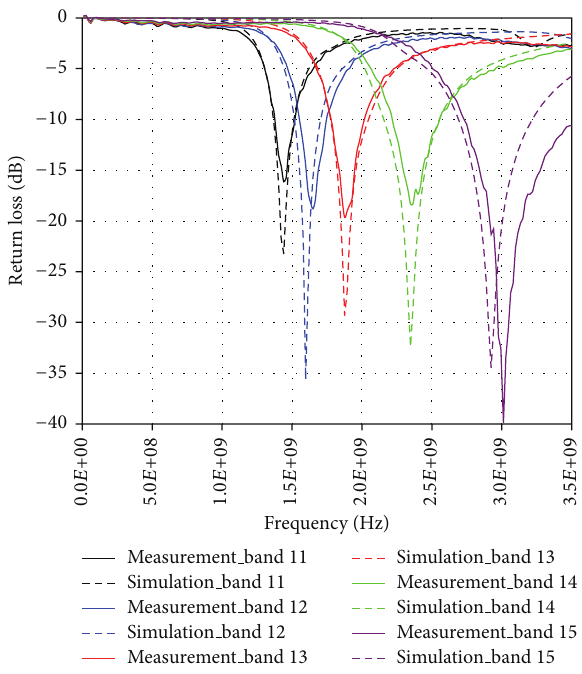
Figure 5: Simulated and measured return losses at bands 10, 11, 12, 13, 14, and 15.